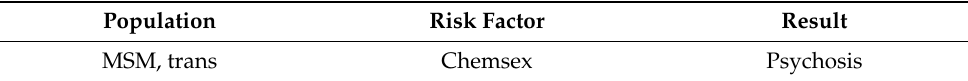
Table 1. PICO strategy. Population Risk Factor Result MSM, trans Chemsex